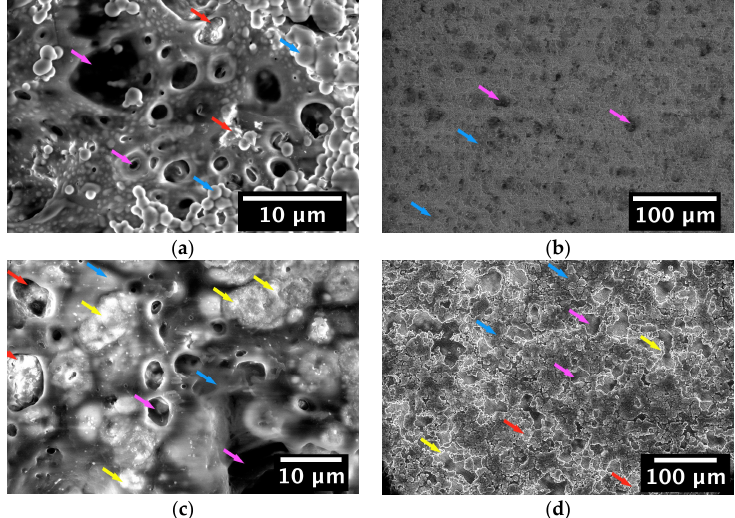
Figure 6. Environmental SEM (ESEM) images showing the microstructure of 45S5 BG/zein coating surfaces produced by EPD and immersed in SBF for: ( a , b ) 1 day and ( c , d ) 14 days. BG particles (red arrow) are embedded in zein (blue arrow) which undergoes a degradation process (magenta arrow) indicated by the holes that appear on the coating surface. Formation of hydroxyapatite (HA) (yellow arrow) is visible on some of the coatings.